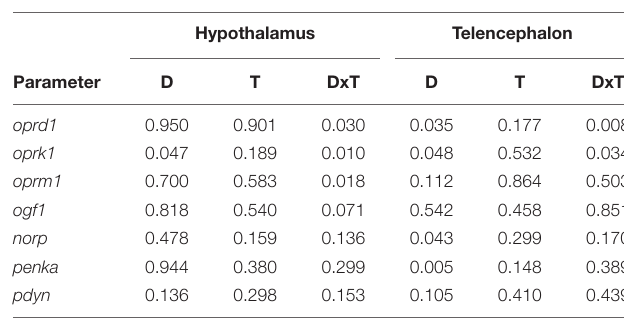
TABLE 3 | p -values obtained after two-way analysis of variance in experiment 2 of and mRNA abundance of transcripts related to the opioid system in hypothalamus and telencephalon of rainbow trout.